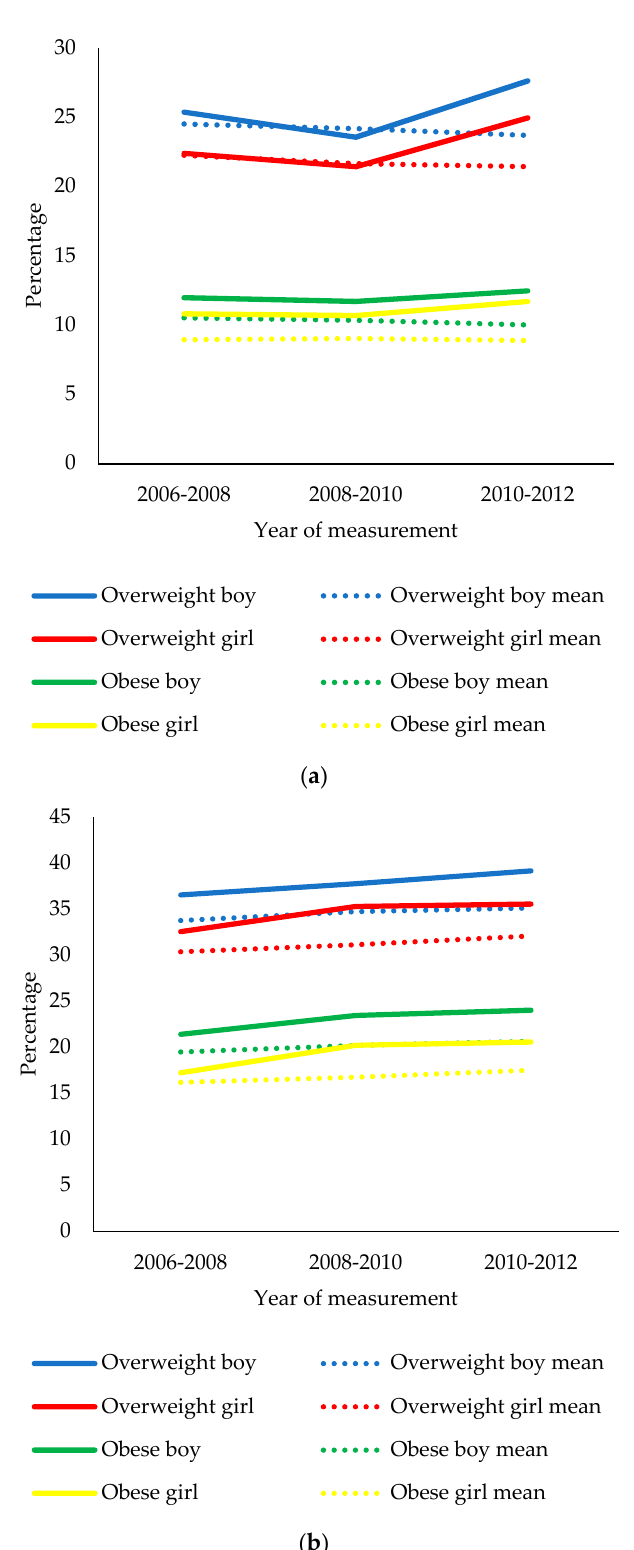
Figure 1. ( a ) Change in the prevalence of overweight and obesity among Reception aged children in Liverpool and England between 2006 and 2012. Mean percentage values for overweight and obese boys and girls = English average. ( b ) Change in the prevalence of overweight and obesity among Year 6 aged children in Liverpool and England between 2006 and 2012. Mean percentage values for overweight and obese boys and girls = English average.